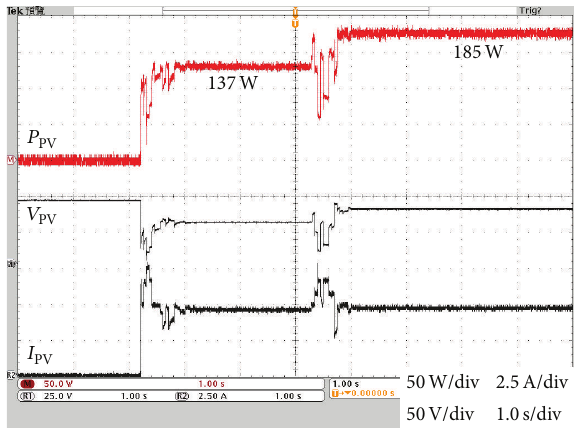
Figure 12: Experimental results for proposed algorithm under vari- ation of solar intensity from 1.0 kW/m 2 , 0.8 kW/m 2 , 0.2 kW/m 2 , and 0.6 kW/m 2 to 1.0 kW/m 2 , 0.8 kW/m 2 , 0.7 kW/m 2 , and 0.6 kW/m 2